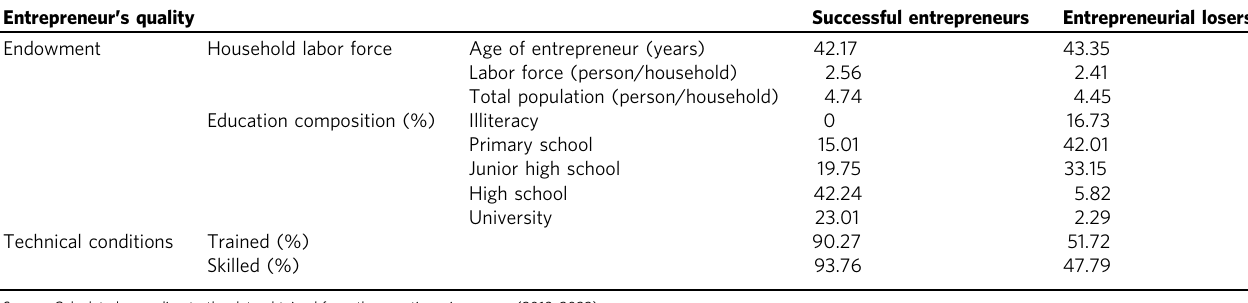
Source: Calculated according to the data obtained from the questionnaire survey (2018 – 2022).